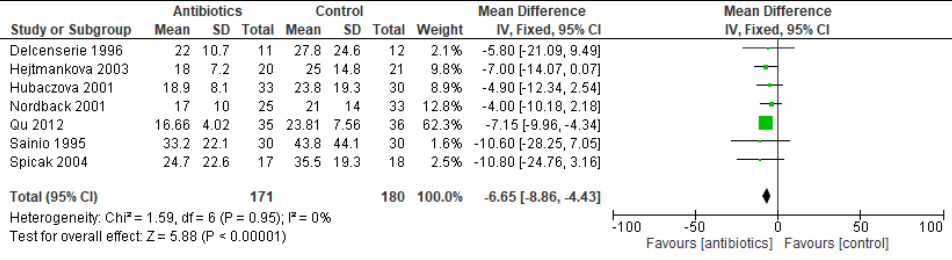
Figure 4. Forest plot of comparison of antibiotics versus control; outcome: length of hospitalization. These data were available from seven trials with a total of 351 patients (171 vs. 180), reporting a significant shortening of the length of hospitalization, by MD − 6.65 days (95% CI − 8.86 to − 4.43) and a heterogeneity of 0%.